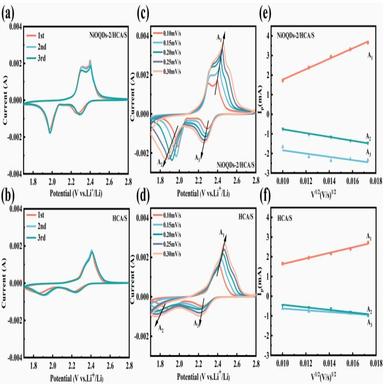
(a, b) CV curves of NiOQDs-2/HCA/S, HCA/S at 0.1 mV s − 1 ; (c, d) CV curves at different scan rates; (e, f) Linear matching of peak point currents for the batteries.